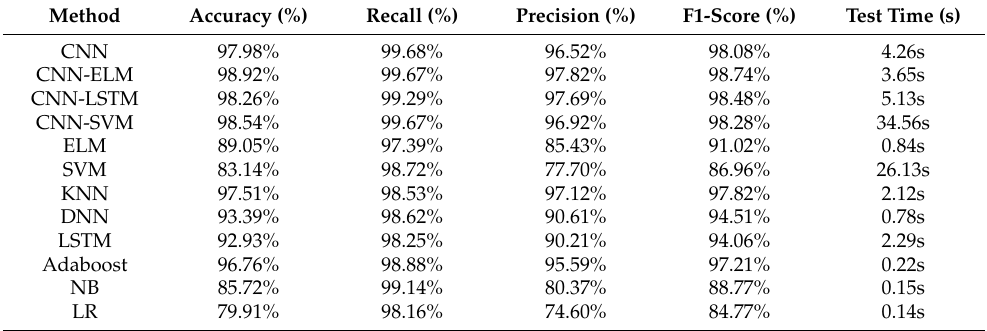
Table 9. Comparison results of CNN-ELM models of 12 feature subsets based on CICIDS-2017 dataset.